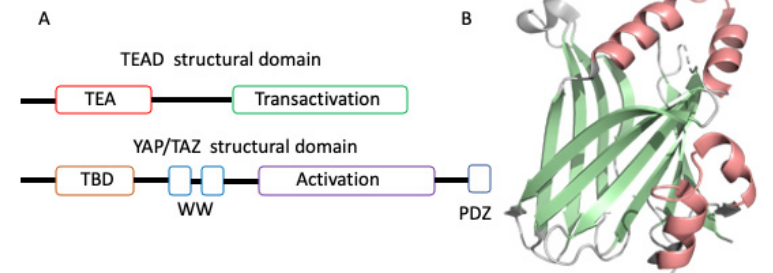
Figure 1. Structural domains of TEAD/YAP-TAZ and TEAD structure. ( A ) Domain architectures of TEAD and YAP/TAZ; ( B ) Ribbon diagram of the apo-TEAD crystal structure of TEAD2 (PDB: 5EMV). Two β sheets are colored in pale green and two helix-turn-helix motifs in salmon.